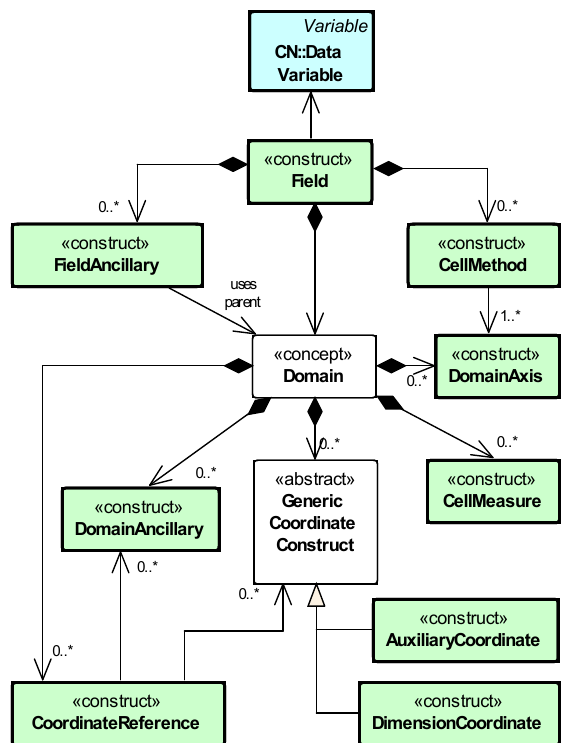
Figure 9. The nine constructs of our CF data model (corresponding to the green layer in Fig. 1) described using UML (Appendix A). In this and all other CF data model diagrams, the CF data model con- structs are labelled with the “construct” stereotype to distinguish them from other data model elements which appear in other dia- grams as green boxes with no label. The field construct corresponds to a CF-netCDF data variable. Relationships between other con- structs and CF-netCDF are given in Figs. 10 and 11. The domain provides the linkage between the field construct and the constructs which describe measurement locations and cell properties. It is not a construct of the data model (see Sect. 4.1) but an abstract concept that is useful for understanding it. Similarly, it is useful to define an abstract generic coordinate construct that can be used to refer to coordinates when the their type (dimension or auxiliary coordinate construct) is not an